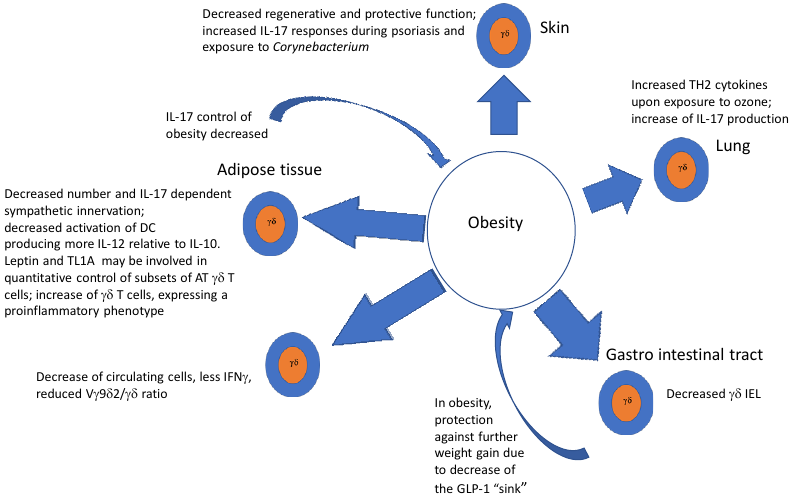
Figure 1 . Effects of obesity on γδ T cell in specific organs. The manner in which obesity affects γδ T cells in the tissues and organs sh own graphically is indicated. The curved arrows indicate feedback effects on obesity [ 32 , 33 , 35 , 37 –40 , 45– 47, 52 , 58 , 61–64 , 66 ]. TH2: T helper